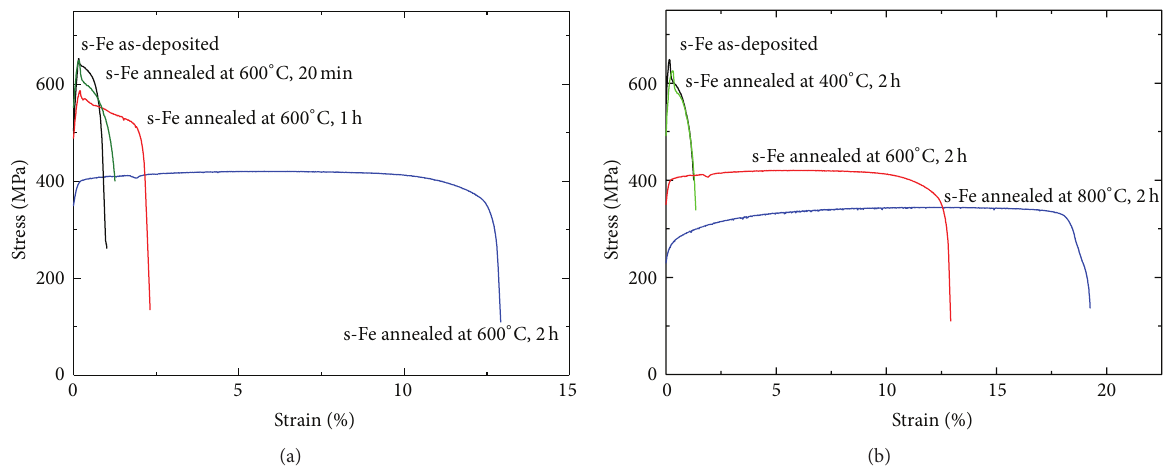
Figure 6: Exemplary stress strain curves of s-Fe annealed at 600 ∘ C for different dwell times (a) and at different temperatures for two hours (b).